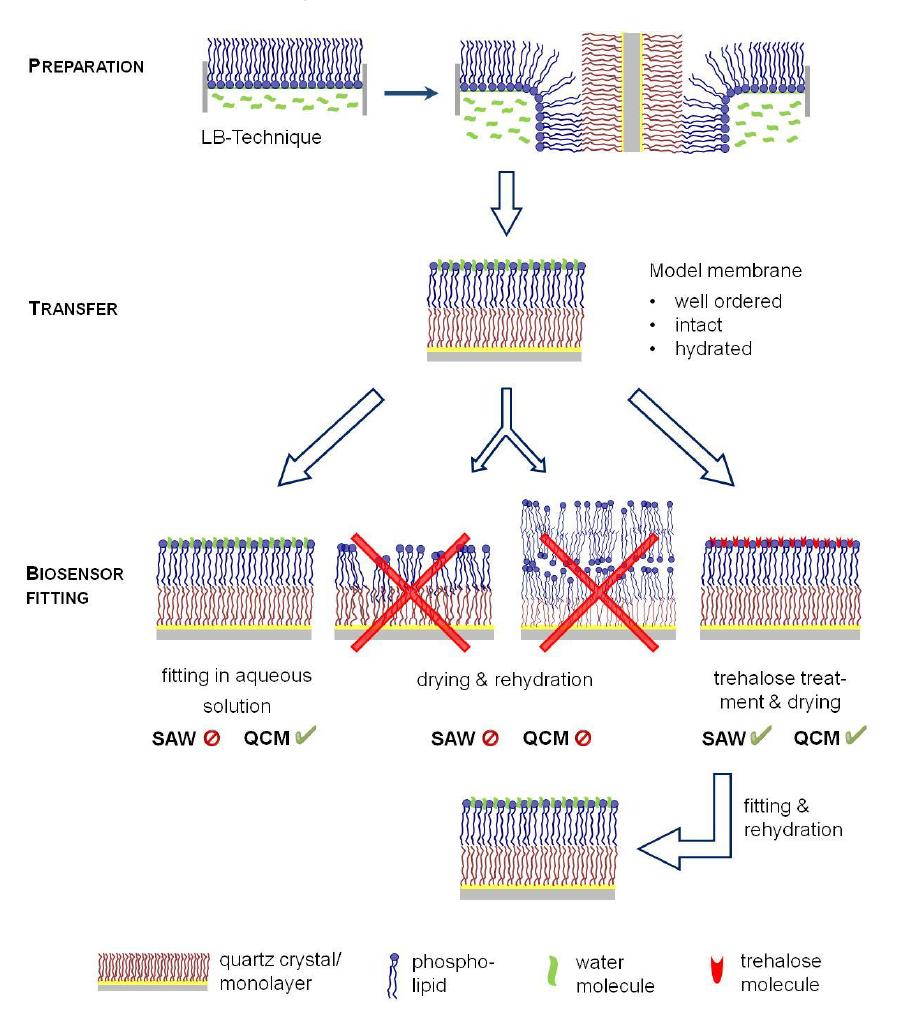
Figure 1. Schematic illustration of model membrane preparation by